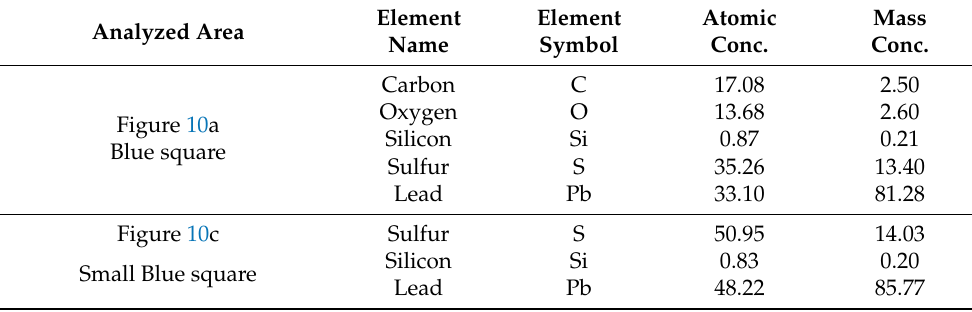
Figure 11. SEM micrographs (BSI) with their EDS spectrums of sintered galena powder: ( a ) fractured surfaces, magnification scale 30 µ m, ( b ) EDS spectrum for ( a ), ( d ) higher magnification, PbS phase, and ( d ) EDS spectrum for ( c ). Blue squares represent the sampled area for EDS. Table 6. Chemical composition of sintered sample of galena